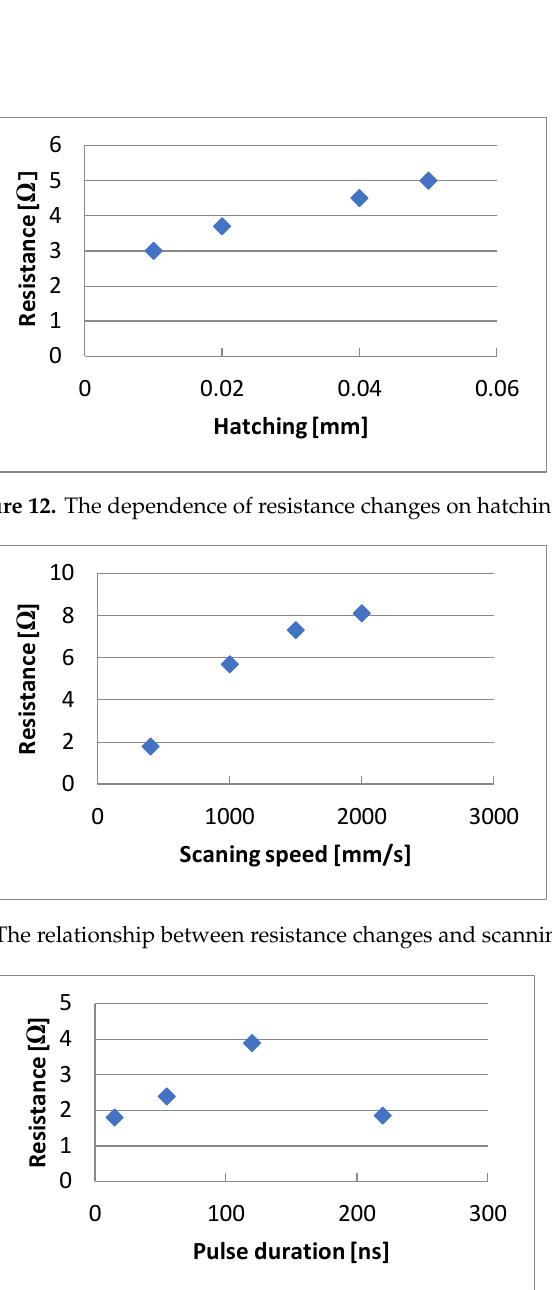
Figure 13. The relationship between resistance changes and scanning speed.